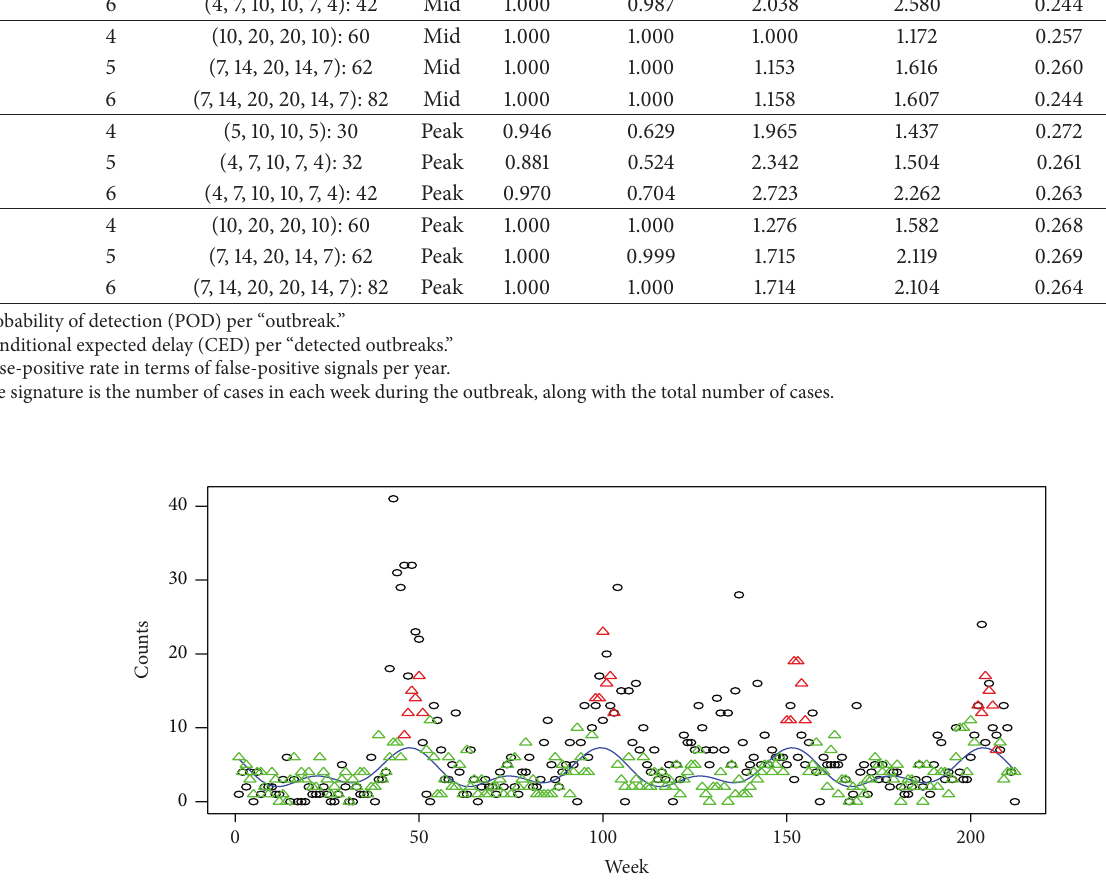
Figure 6: Simulated (triangles) and real (circles) Pertussis case counts, Missouri, Eastern region, 2010–2013. Simulated outbreaks are the red triangles. The fitted trigonometric model is the blue